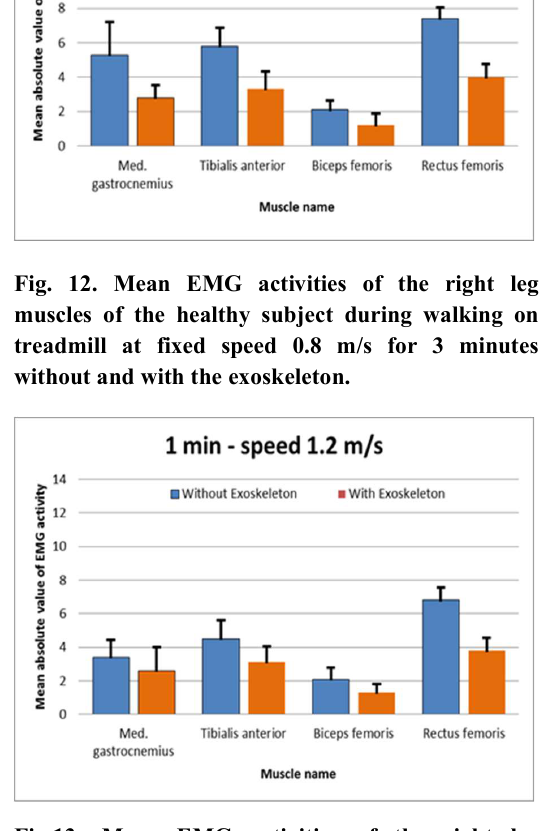
Fig.13: Mean EMG activities of the right leg muscles of the healthy subject during walking on treadmill at fixed speed 1.2 m/s for 1 minute without and with the exoskeleton.